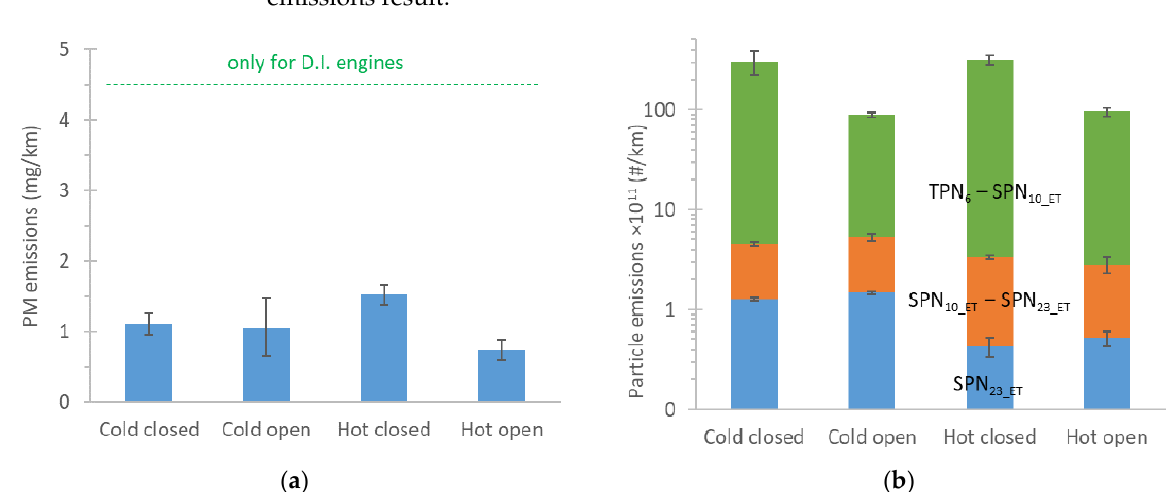
Figure 4. Particulate emissions with open and closed configurations for cold start and hot start WMTCs: ( a ) Particulate matter (PM) mass for different configurations; ( b ) Solid (SPN) and total particle number (TPN) for various lower sizes (6, 10, 23 nm). For SPN the system with evaporation tube (ET) was used.